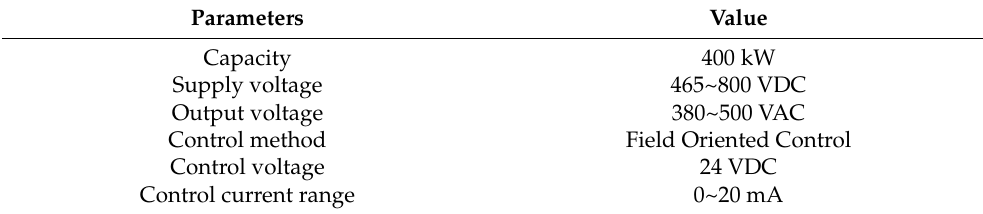
Table 2. Specifications of the DC/AC inverter.